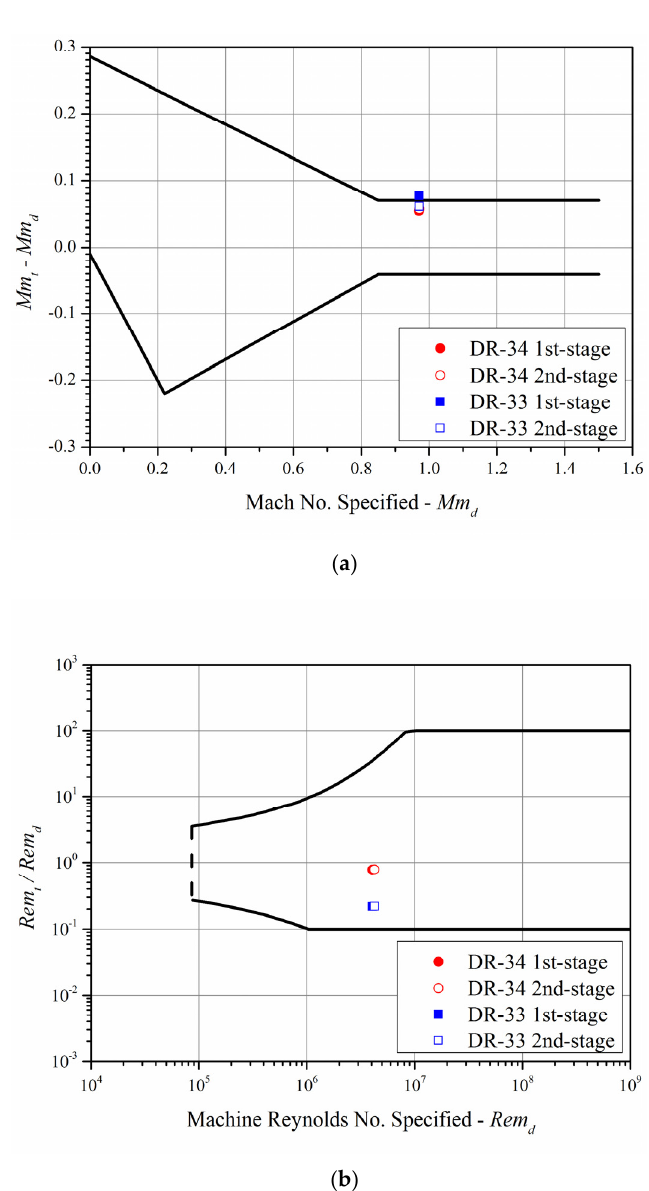
Figure 6. Comparison of allowable range diagrams for alternative gases. ( a ) Allowable machine Mach number and ( b ) allowable machine Reynolds number.